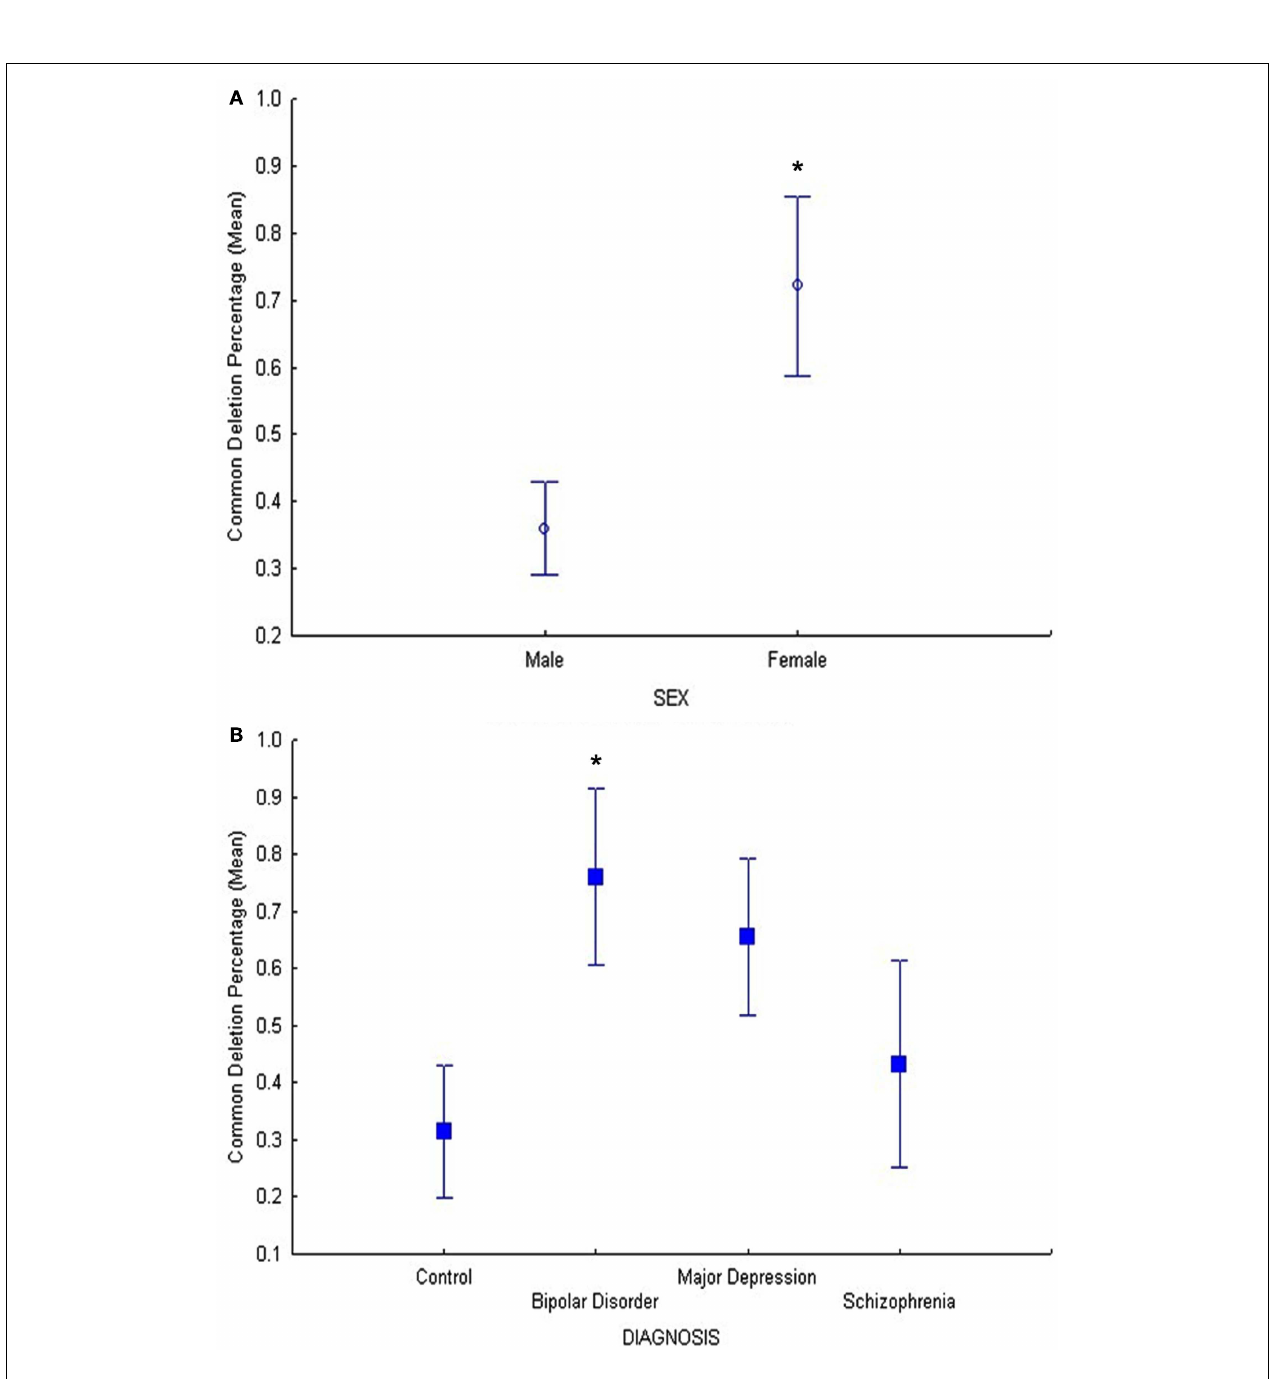
displayed. (B) In cohort 2, the BD group showed a significant increase in the common deletion compared to controls ( p = 0.022) and MDD showed a